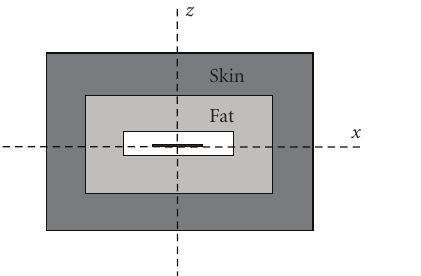
Figure 3: Patch implanted inside the model (4mm Skin, 4mm Fat, 1mm cavity).